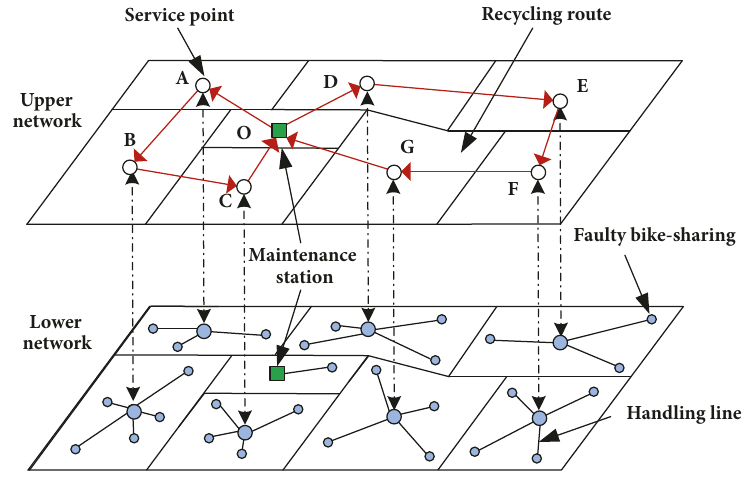
Figure 2: Multilevel faulty bike-sharing recycling